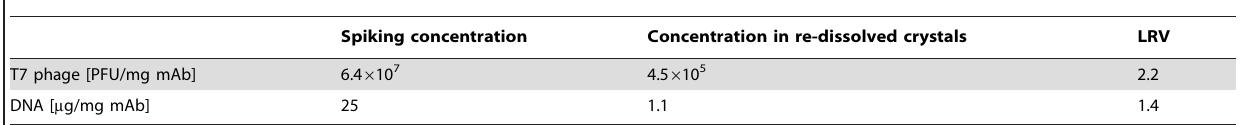
Table 2. Results of DNA and phage spiking.